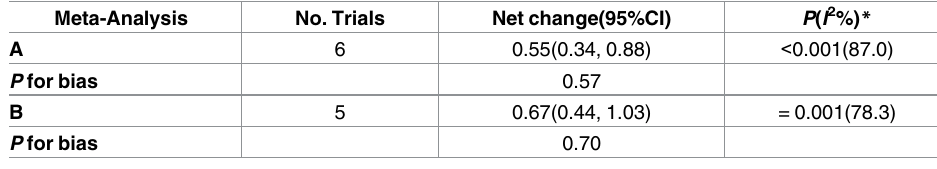
Table 2. Publication bias in sensitivity